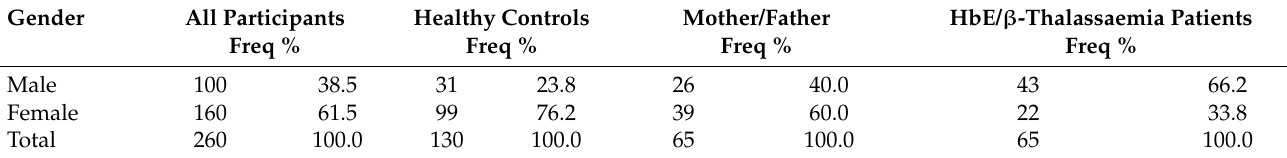
Table 3. The frequencies and percentages for each group based on